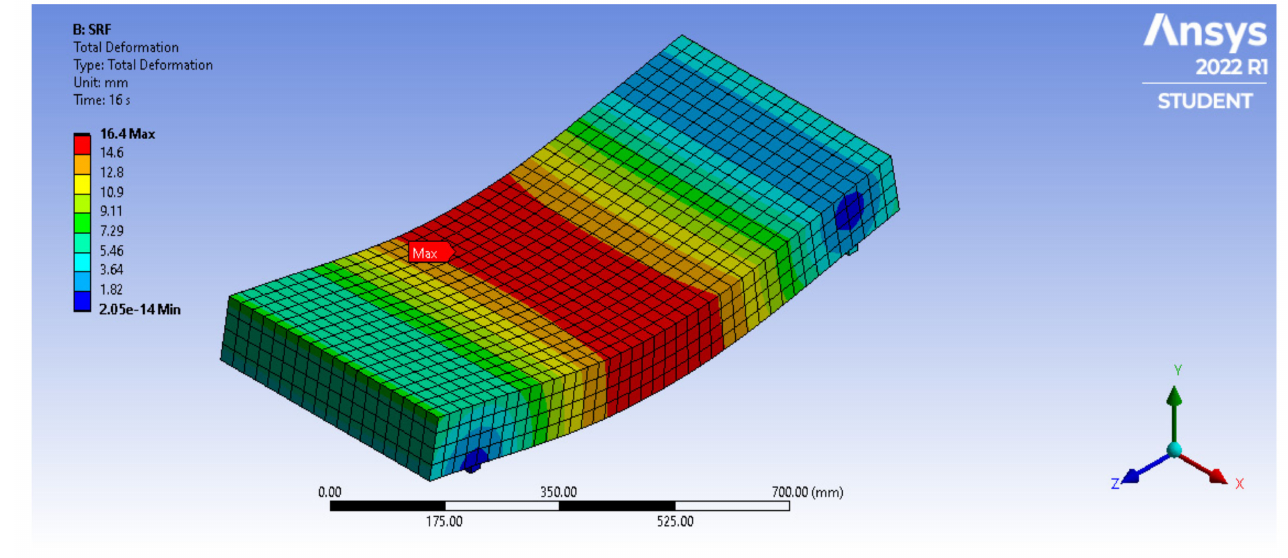
Figure 17. Ultimate deflection of SRF